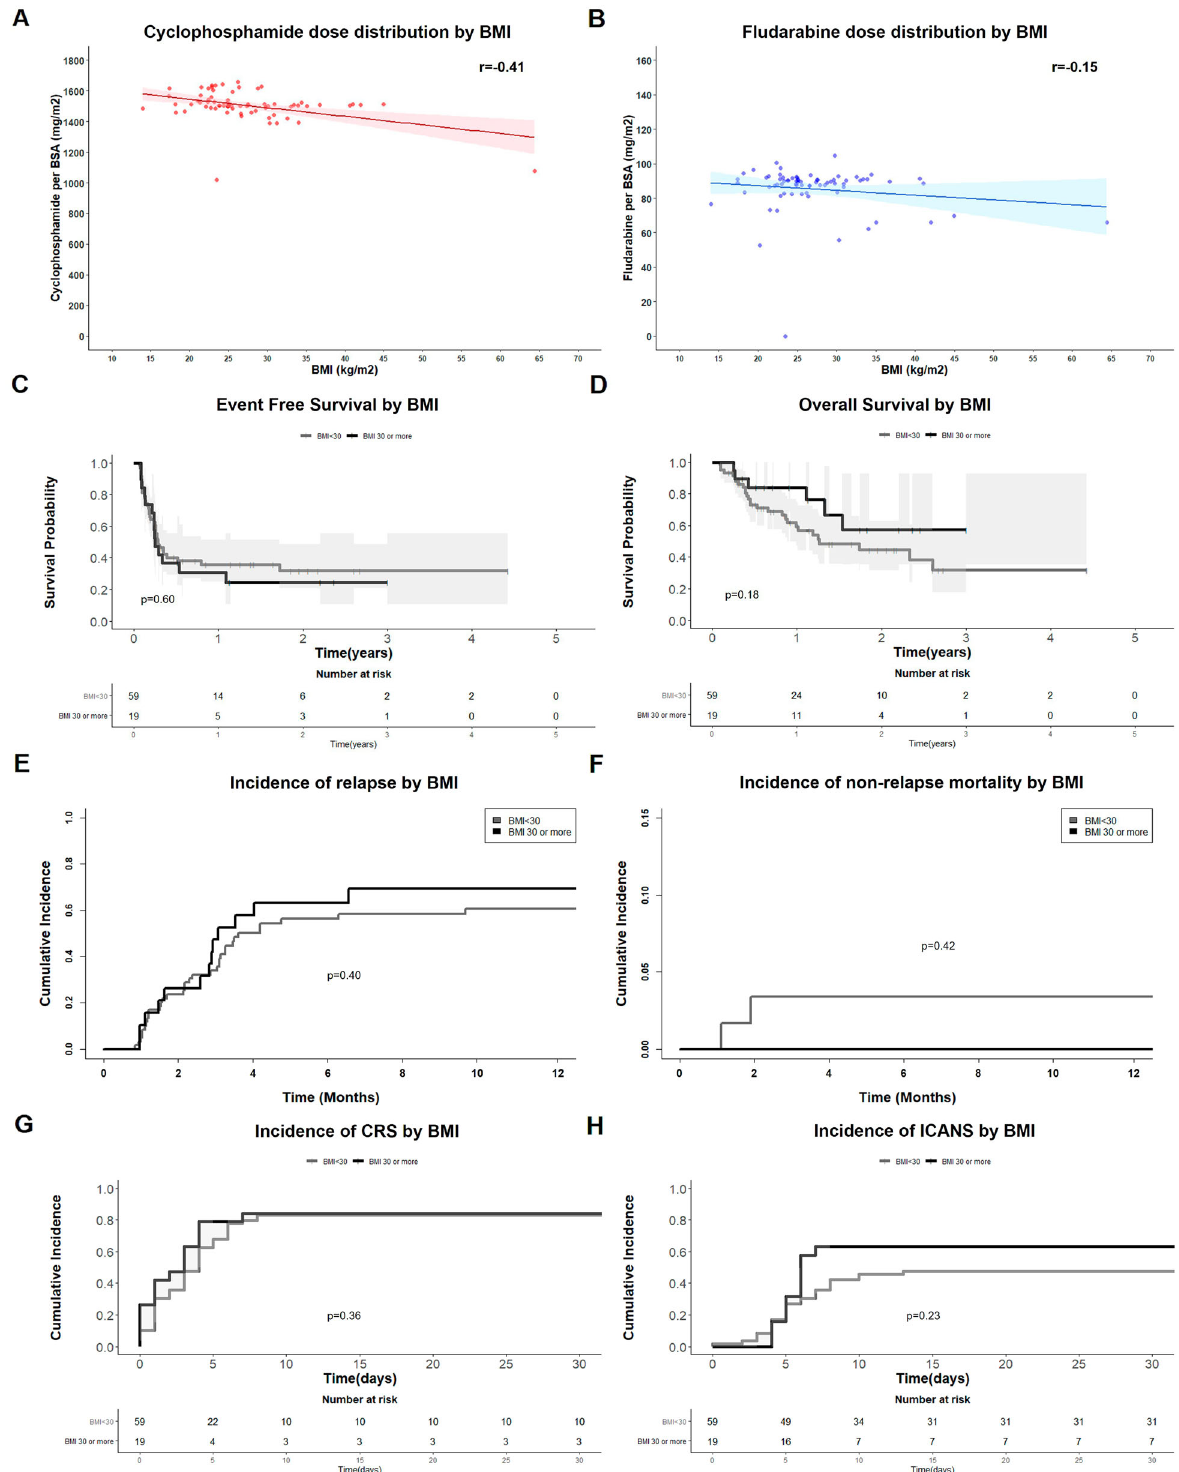
Fig. 1 Correlation between body mass index (BMI) and administered dose of lymphodepletion chemotherapy and impacts of BMI on clinical outcomes. A Distribution of total delivered cyclophosphamide per body surface area and body mass index of 78 patients treated with axicabtagene ciloleucel. B Distribution of total delivered fl udarabine per body surface area and body mass index of 78 patients treated with axicabtagene ciloleucel. C Event Free Survival after axicabtagene ciloleucel as strati fi ed by obesity status. D Overall Survival after axicabtagene ciloleucel as strati fi ed by obesity status. E Cumulative incidence of relapse after CAR T cell therapy as strati fi ed by obesity status. F Cumulative incidence of non-relapse mortality as strati fi ed by obesity status. G Cumulative incidence of CRS after axicabtagene ciloleucel as strati fi ed by obesity status. H Cumulative incidence of ICANS after axicabtagene ciloleucel as strati fi ed by obesity status.